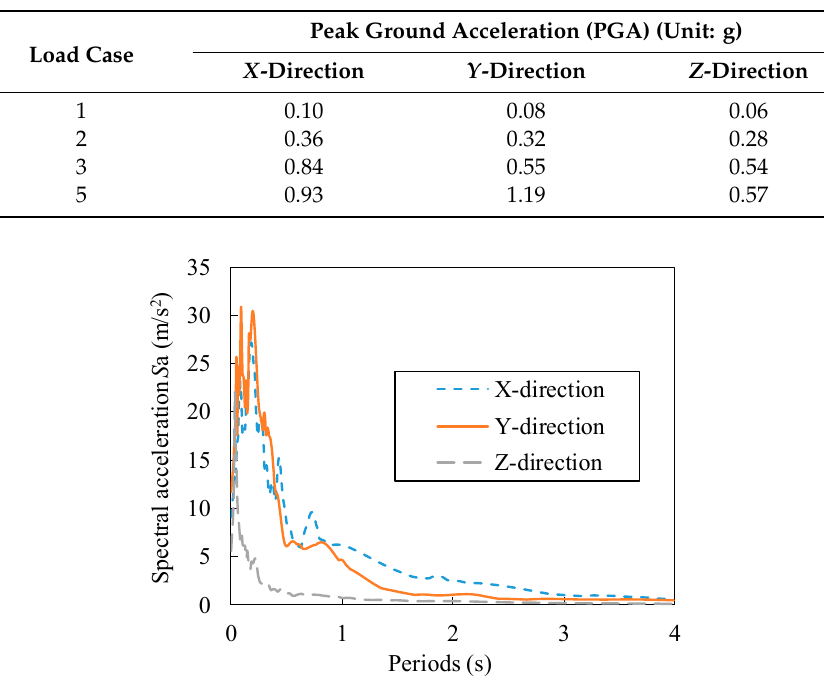
Figure 8. Pseudo-acceleration spectra of Load Case 5.